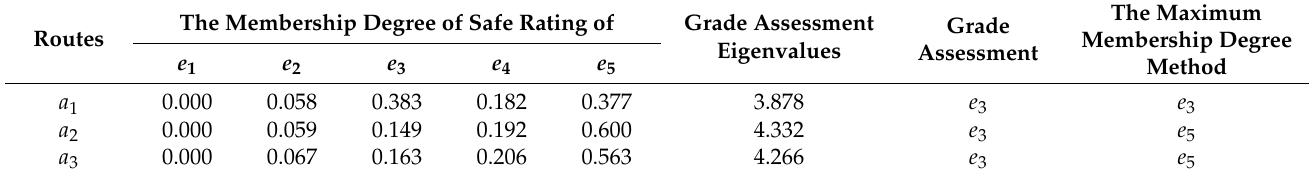
Table 5. Results for grade assessment of waterway navigation safe routes ( λ = 0 ) .